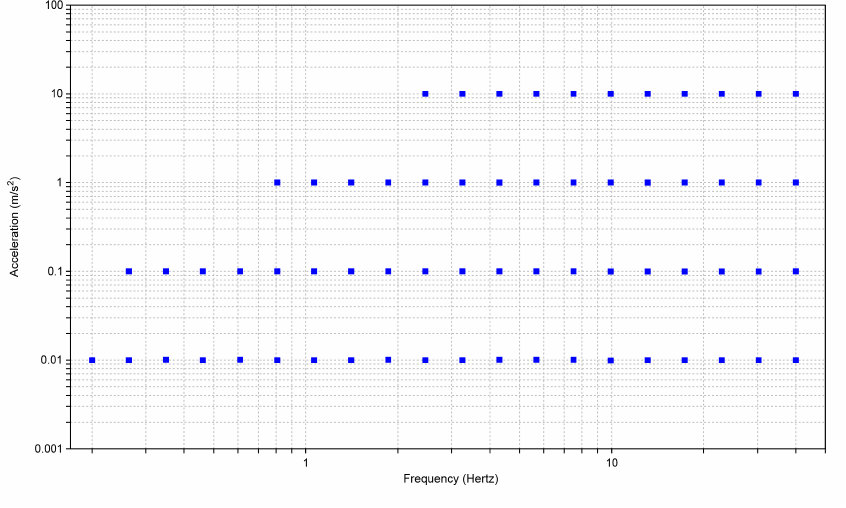
Figure 5. Parameters imposed for setting sinusoidal movements during measuring protocol. The blue squares represent the accelerations with respect to the frequency for each shaking test.